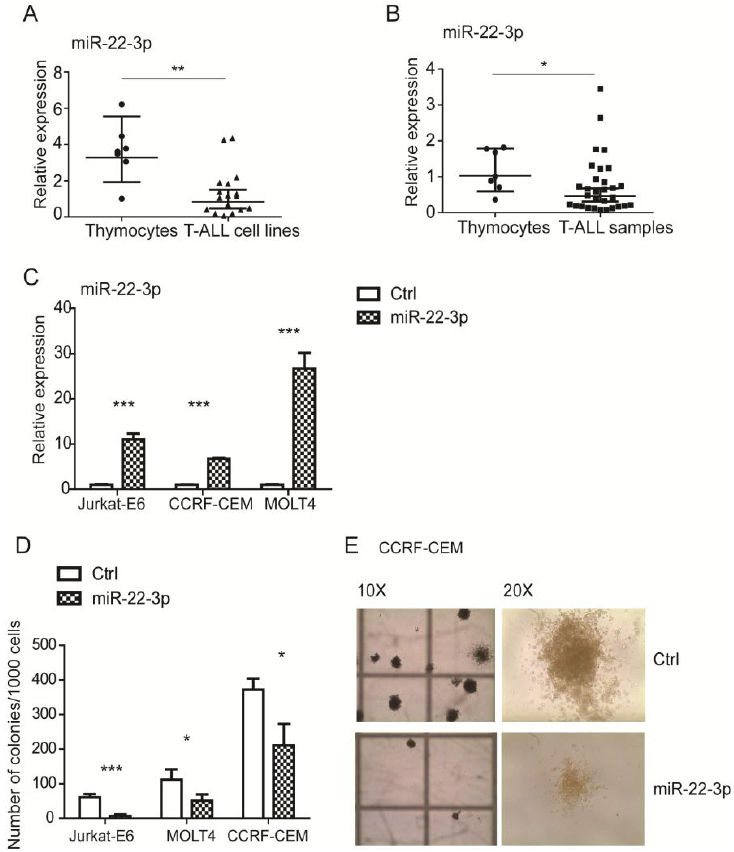
Figure 3. miR-22-3p is downregulated in T-ALL cells and negatively affects colony formation. ( A , B ) qPCR analysis of miR-22-3p expression in T-ALL cell lines ( n = 17) and primary T-ALL samples ( n = 30) compared with normal thymocytes ( n = 7). ( C ) qPCR analysis of miR-22-3p overexpression in Jurkat-E6, CCRF-CEM, and MOLT4 cell lines. ( D , E ) T-cell lines showing the effects of miR-22-3p overexpression in colony-forming unit (CFU) assays using methylcellulose-based medium (* p < 0.05, ** p < 0.01, and *** p < 0.001). Representative images of CCRF-CEM colonies using an inverted microscope at different magnifications (10× and 20×). Data are represented as mean ± SD. Assays were performed in triplicate. (* p < 0.05, ** p < 0.01, and *** p < 0.001.).